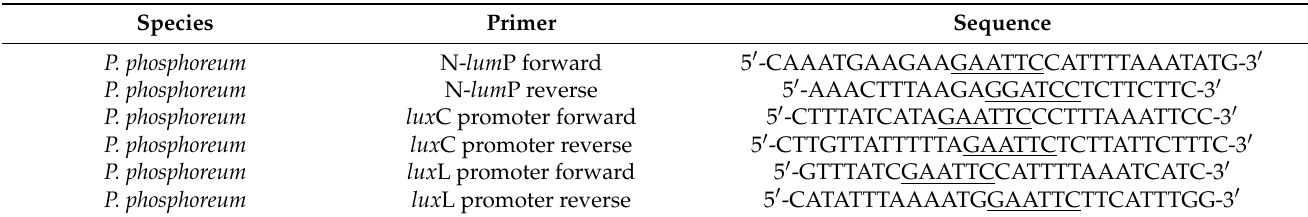
Table 2. Oligonucleotide primers for PCR amplification of the lux promoter region. Restriction sites for EcoR I (GAATTC) and Bam HI (GGATCC) are